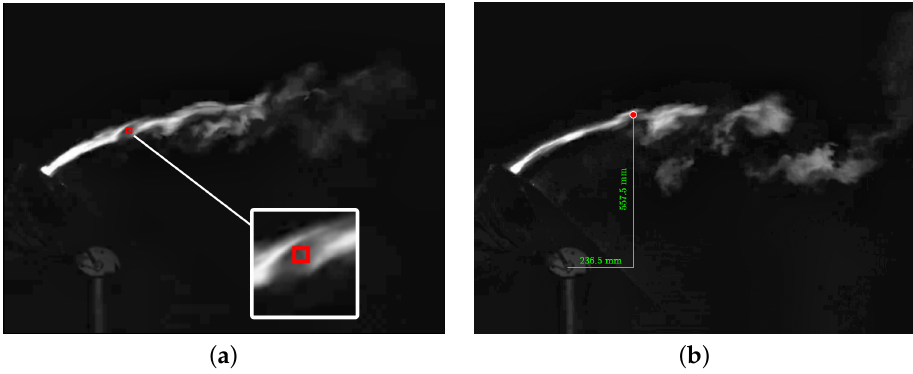
Figure 8. Example of the analysed ROI: ( a ) 9 × 9 pixels ROI; ( b ) coordinates of the